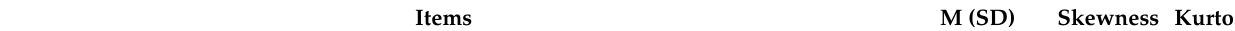
Table 1. Mean, standard deviation, skewness, and kurtosis of the indicators of the WFTS.